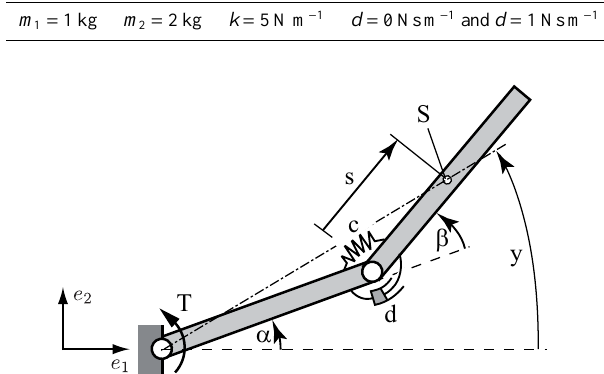
Figure 7. Rotational arm with passive